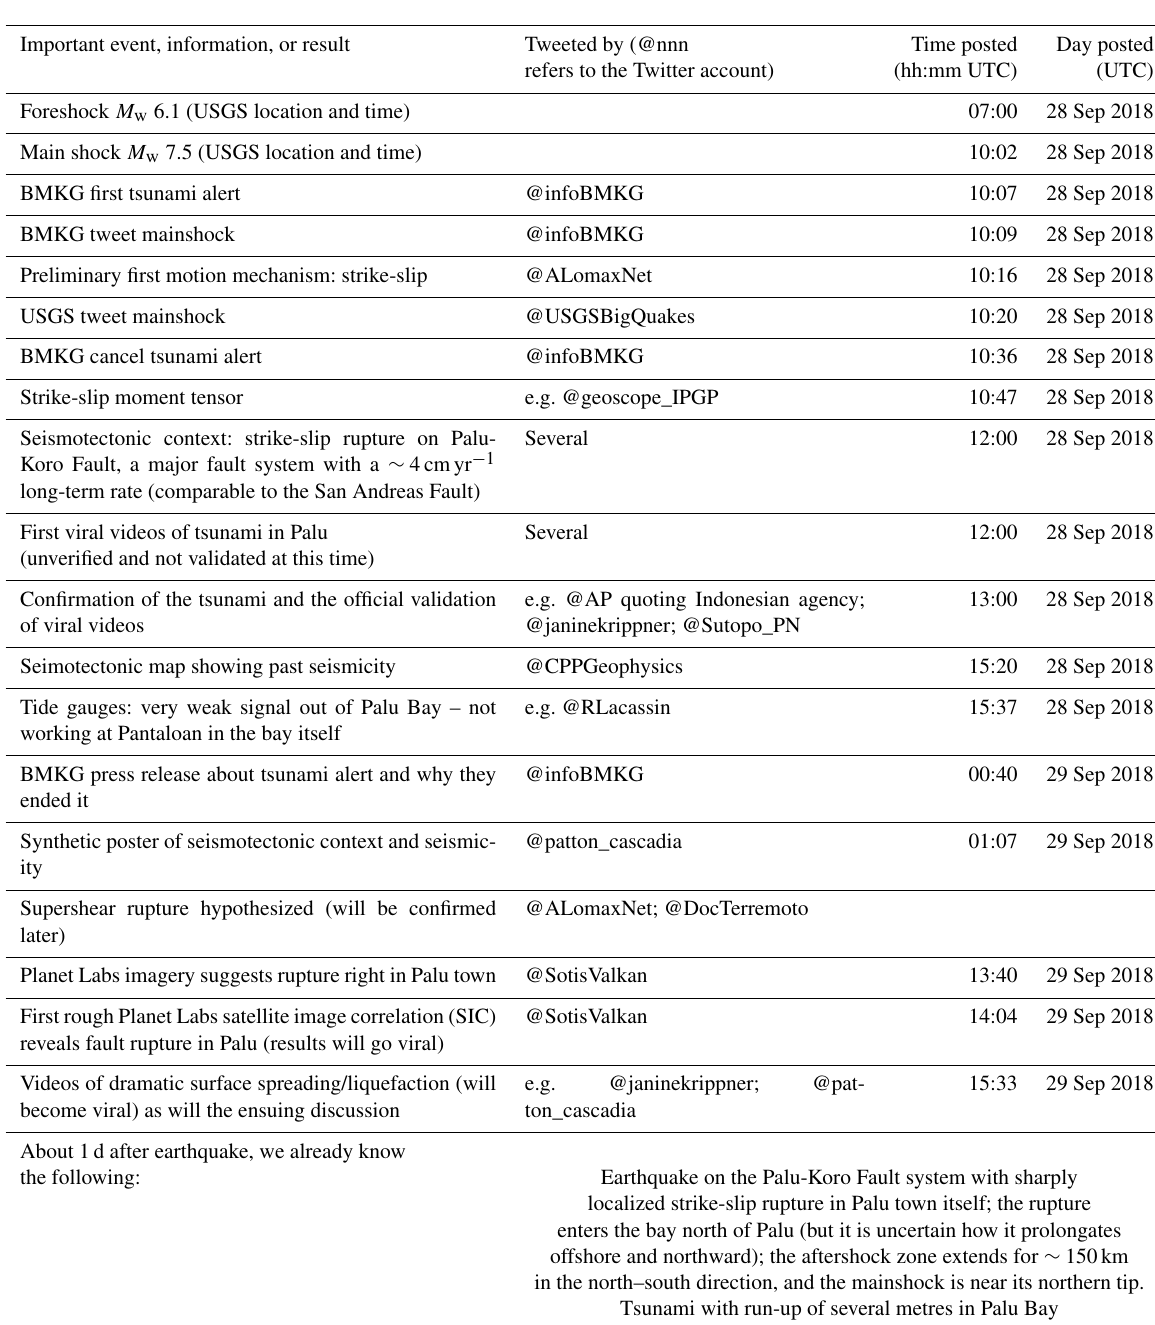
Table A1. Timetable of main events and preliminary geophysical information posted on Twitter about the Palu earthquake and tsunami of 28 September 2018 (Table S1 provides links to the relevant